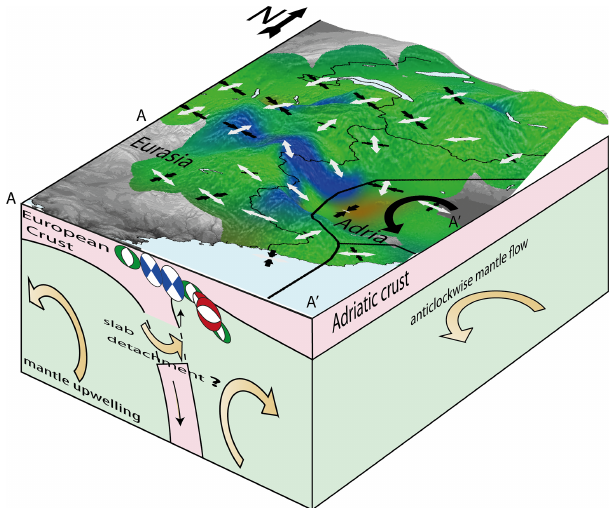
Figure 12. Interpretative 3D block diagram of the current geody- namics of the Western Alps. The southern front of the diagram represents the interpretative A–A (cid:48) cross section running from the Pelvoux massif to the Po plain. The main observations are repre- sented as in Fig. 11a. Forces suggested to be involved together to produce the observed seismic deformation field (far-field plate kine- matics and buoyancy forces) are represented as solid arrows: Adria anticlockwise rotation is shown as a black arrow, and mantle up- welling and possible slab detachment are shown as gold